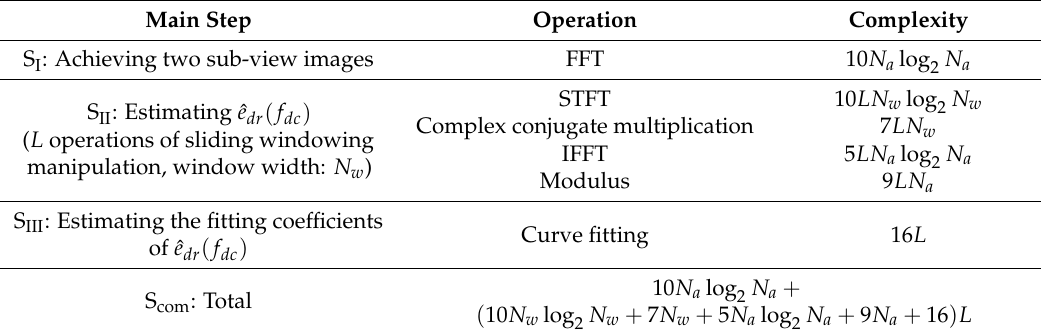
Table 3. The complexity of the main steps of the improved MAM (IMAM)